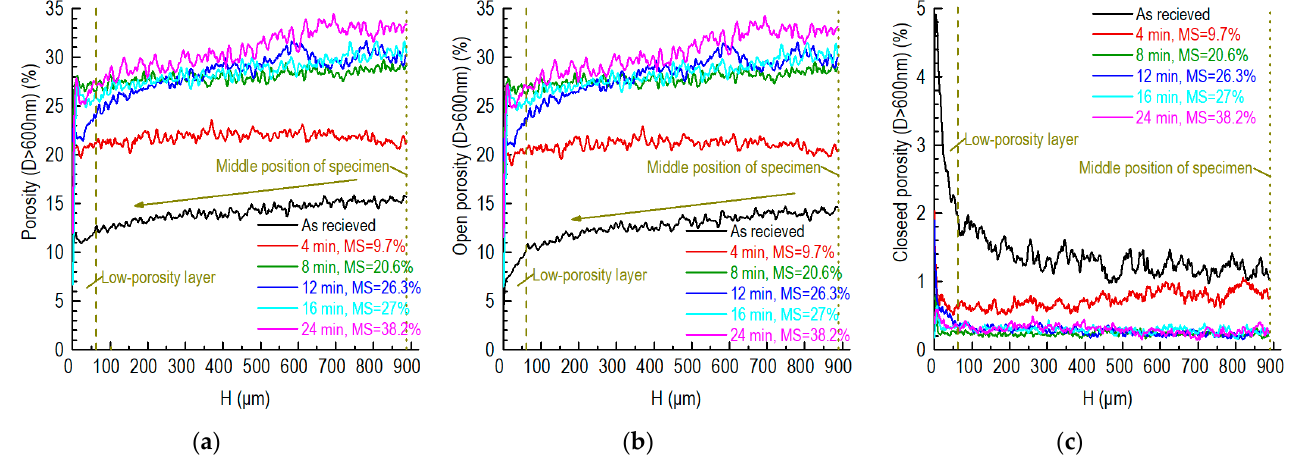
Figure 11. Axial profiles of porosities of partially SiC-coated graphite specimens: ( a ) porosity; ( b ) open porosity; ( c ) closed porosity (MS: mass loss).